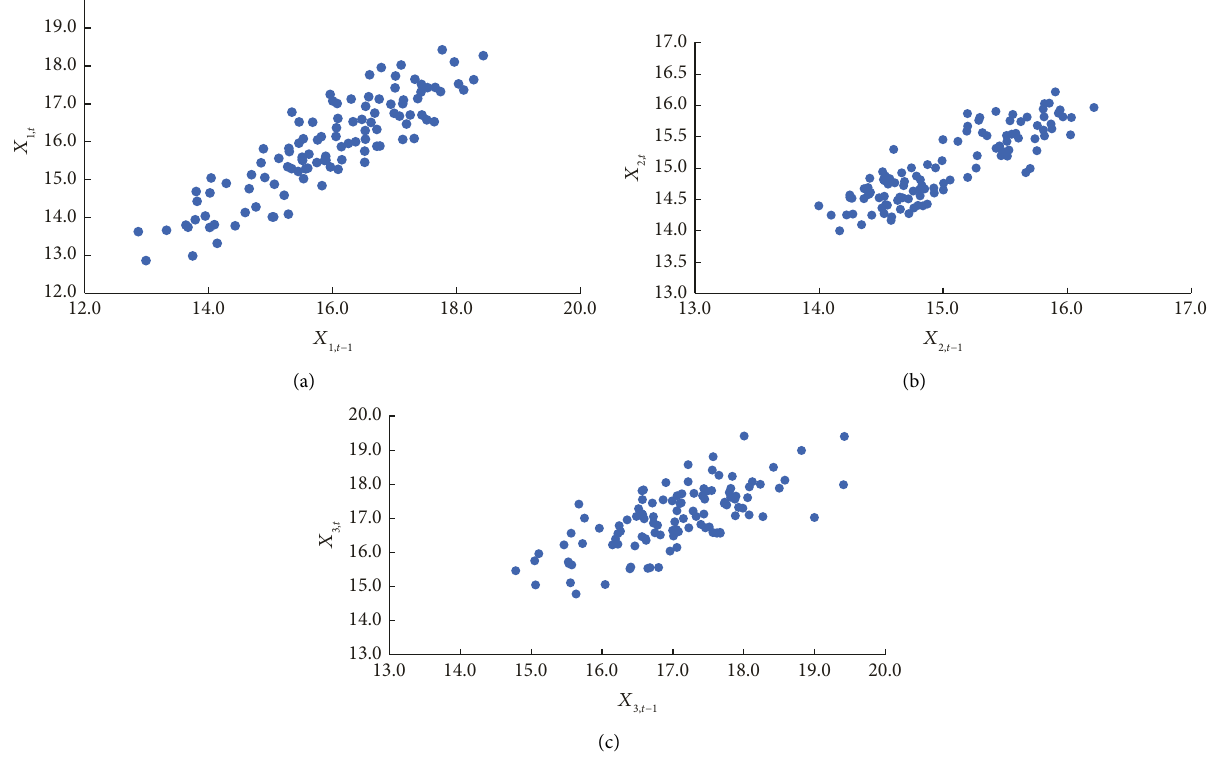
, (b) X , and (c) X 1 ,t 2 ,t